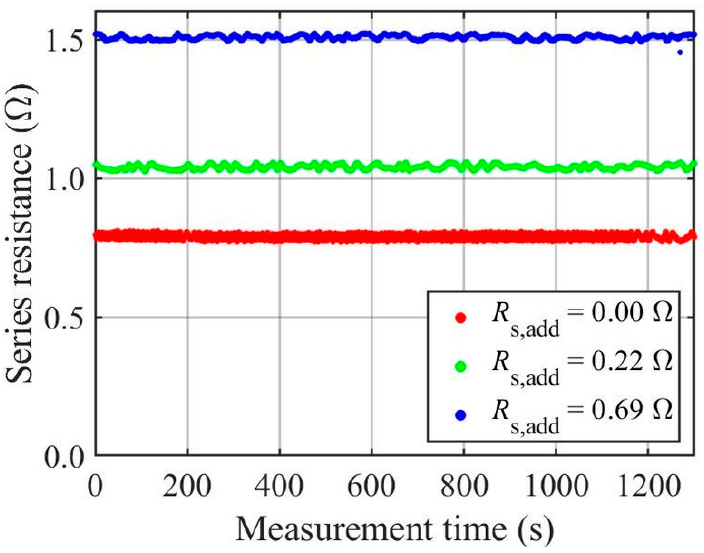
Figure 19. Fitted series resistance values using additional series resistors as a function of measurement time for the entire I – U curves.